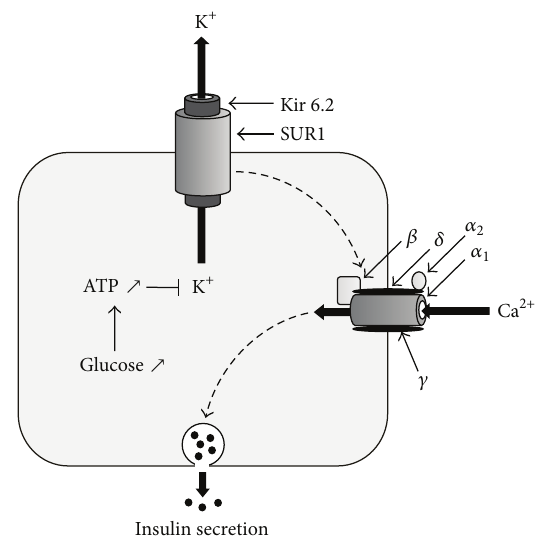
Figure 2: Mechanism of insulin secretion by the KATP channel in pancreatic beta cells. The Kir6.2 and SUR1 proteins in the KATP channel mediate insulin secretion. An increase in glucose levels stimulates the KATP channel to allow the entry of potassium ions. An increase in intracellular potassium ions depolarizes the cell membrane and induces calcium channels to increase intracellular free Ca 2+ levels. The calcium ions trigger other components of the insulin secretion pathway to release granules at or near the plasmamembrane.KATP:ATP-sensitivepotassiumchannel;Kir6.2: inward-rectifier potassium ion channel; SUR1: sulfonylurea receptor 1; ATP: adenosine triphosphate; K + : potassium ion; Ca 2+ : calcium ion. The calcium channel is composed of 𝛼 1 , 𝛼 2 , 𝛽 , 𝛾 , and 𝛿